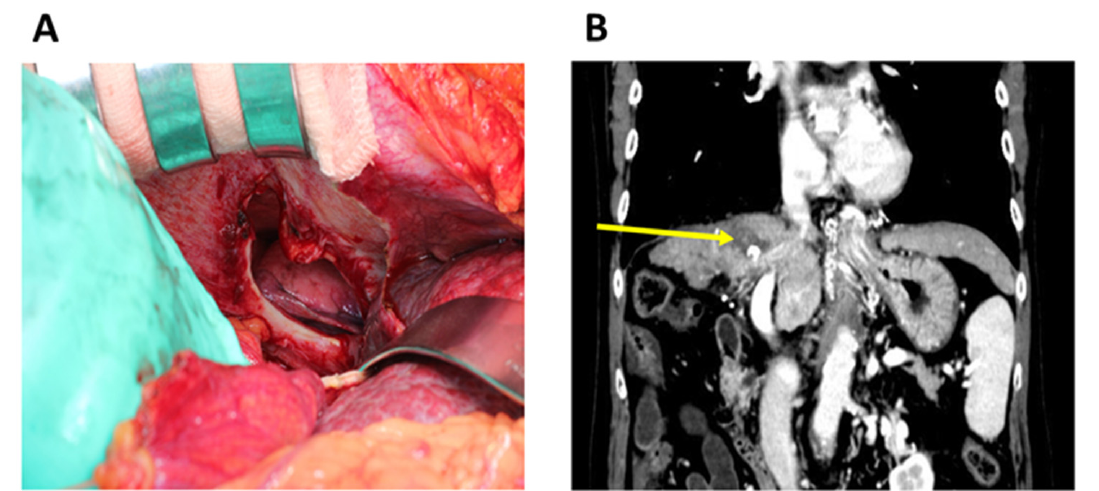
Figure 2. ( A ) Intraoperative images of a hole detected after returning the hernial sac. ( B ) The lesion of the diaphragmatic injury is located on the estimated needle track of the RFA (radiofrequency ablation) conducted for hepatocellular carcinoma (arrow).